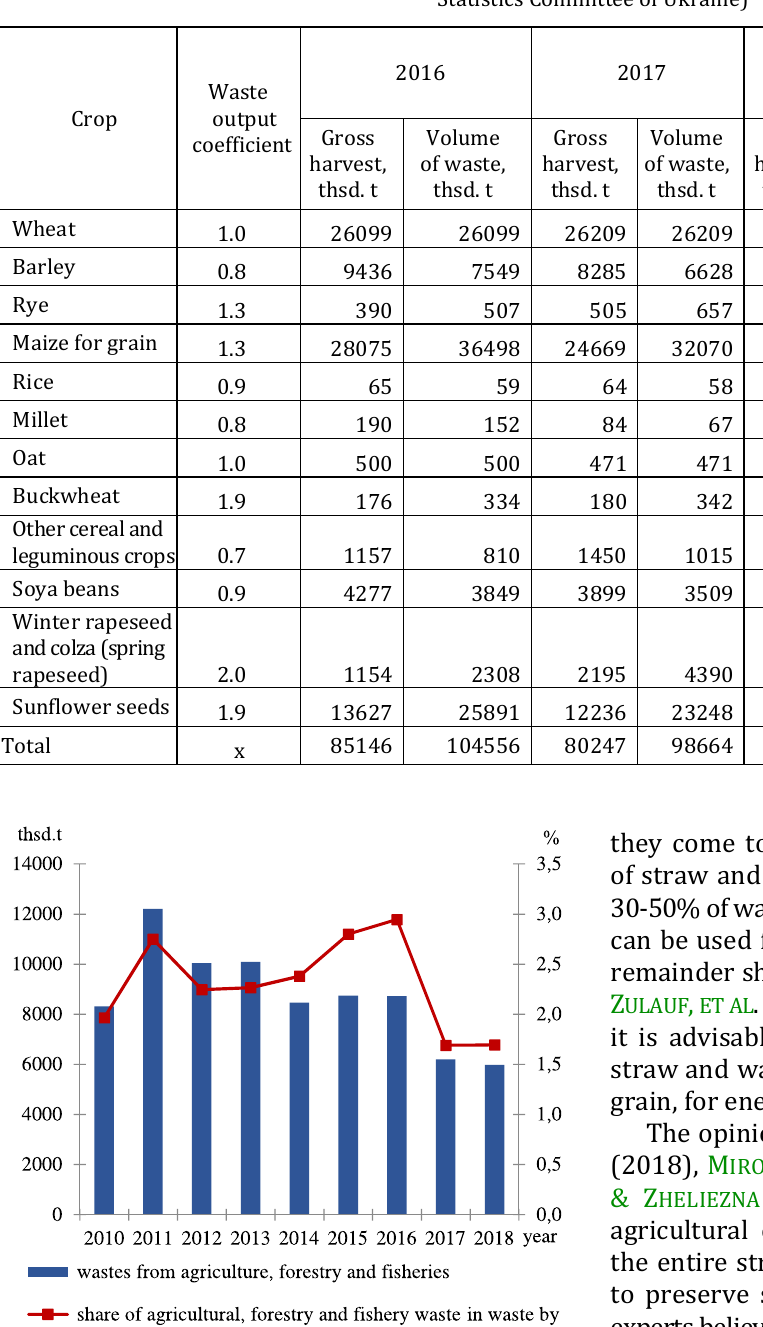
Fig. 2. Waste generation from agriculture, forestry and fisheries and their share in total waste by types of economic activity and households for 2010-2018 in Ukraine (Source: composed by the authors according to the State Statistics Committee of